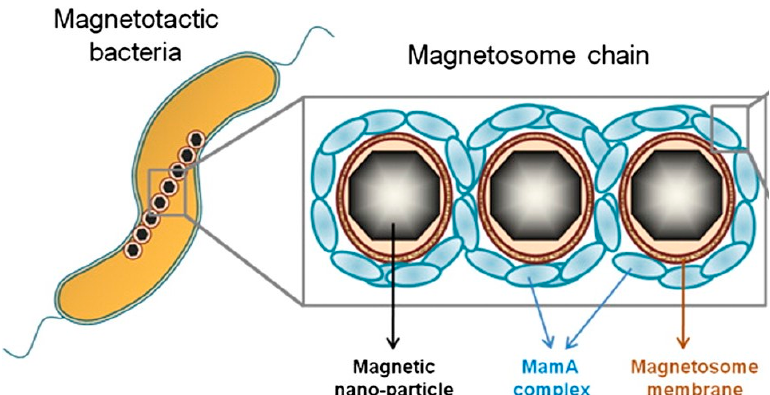
Figure 2. Schematic presentation of magnetotactic bacterium with a magnetosome chain. The magnetosome consists of lipid invaginations, each one enclosing a ferrimagnetic nanocrystal. The 1D chain of magnetosomes is decorated by MamA homo-oligomers. Reproduced from [24]. Copyright 2011, with permission from PNAS.